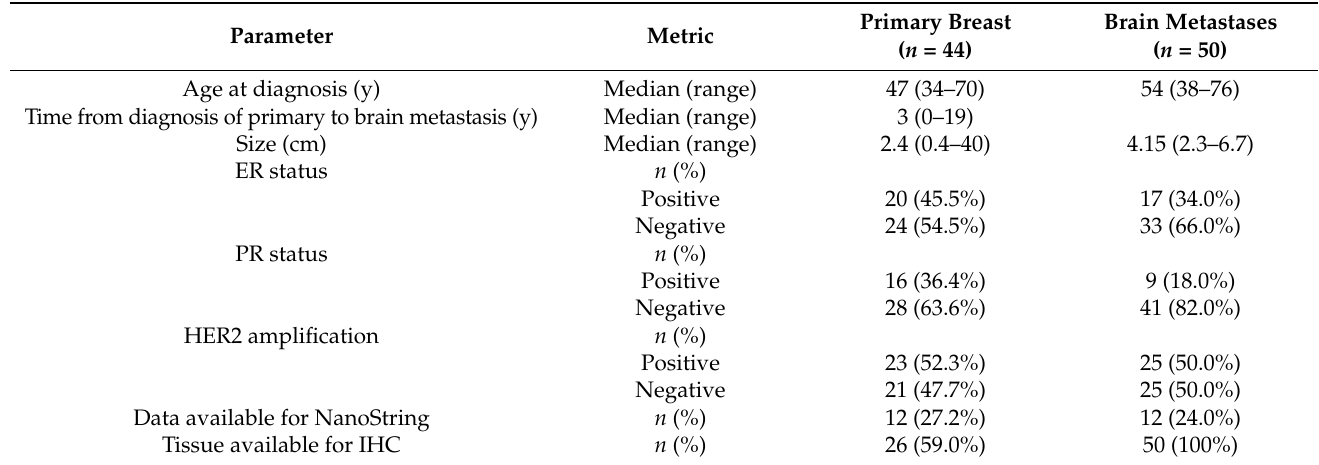
Table 1. Baseline characteristics of the study